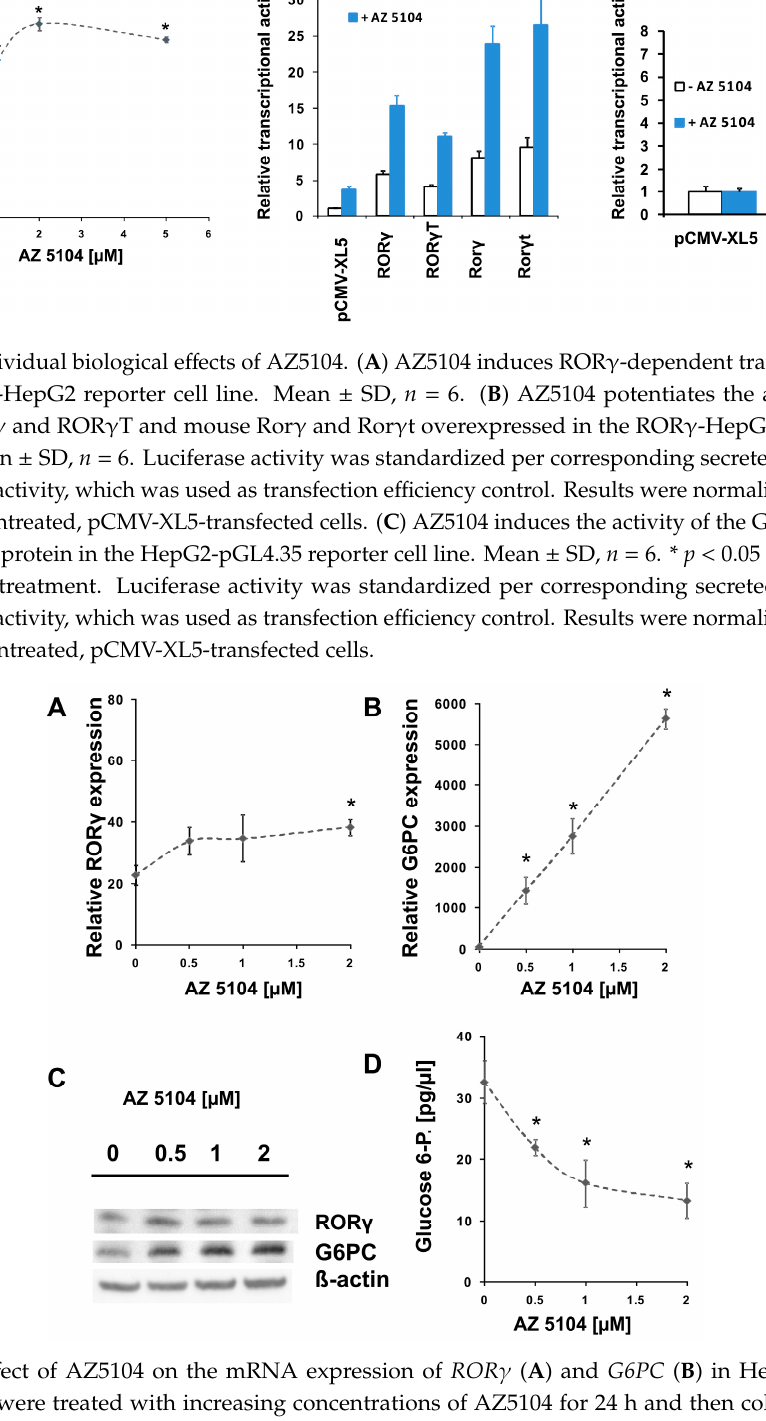
Figure 2. Individual cytotoxic effects of AZ5104. ( A ) Results of the neutral red uptake assay in HepG2 cells treated with increasing concentrations of AZ5104 for 24 h. Mean ± SD, n = 6. ( B ) Results of cell viability determined with the CellTiter-Glo assay in CD4+ cells differentiating towards Th17 cells in the presence of AZ5104 for 5 days. Mean ± SD, n = 8. * p < 0.05 compared with control cells. Figure 3. Individual biological effects of AZ5104. ( A ) AZ5104 induces ROR γ -dependent transcription in the ROR γ -HepG2 reporter cell line. Mean ± SD, n = 6. ( B ) AZ5104 potentiates the activity of human ROR γ and ROR γ T and mouse Ror γ and Ror γ t overexpressed in the ROR γ -HepG2 reporter cell line. Mean ± SD, n = 6. Luciferase activity was standardized per corresponding secreted alkaline phosphatase activity, which was used as transfection efficiency control. Results were normalized to the activity of nontreated, pCMV-XL5-transfected cells. ( C ) AZ5104 induces the activity of the GAL4-DBD ROR γ fusion protein in the HepG2-pGL4.35 reporter cell line. Mean ± SD, n = 6. * p < 0.05 compared with control treatment. Luciferase activity was standardized per corresponding secreted alkaline phosphatase activity, which was used as transfection efficiency control. Results were normalized to the activity of nontreated, pCMV-XL5-transfected cells.